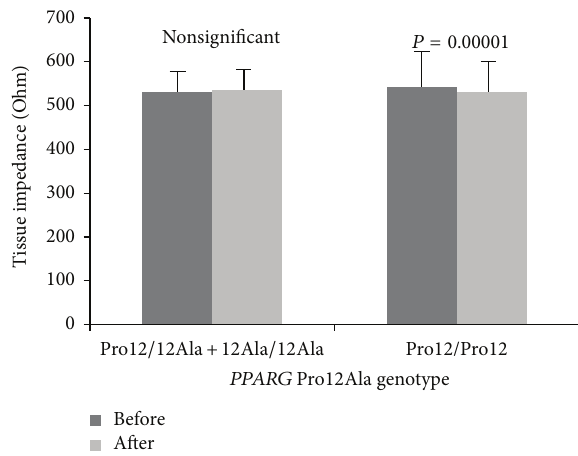
Figure 1: Changes in tissue impedance observed in participants ( PPARG 12Ala carriers versus Pro12 homozygotes) before and after the completion of 12-week training program.